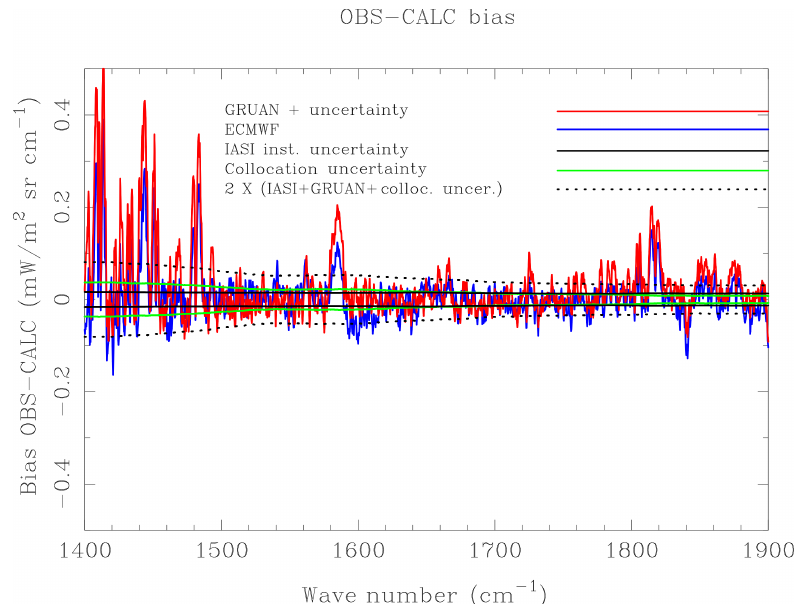
Figure 8. Same as Fig. 7 but artificially adding 2.5% in absolute terms of relative humidity to the complete GRUAN sonde profile before calculating its